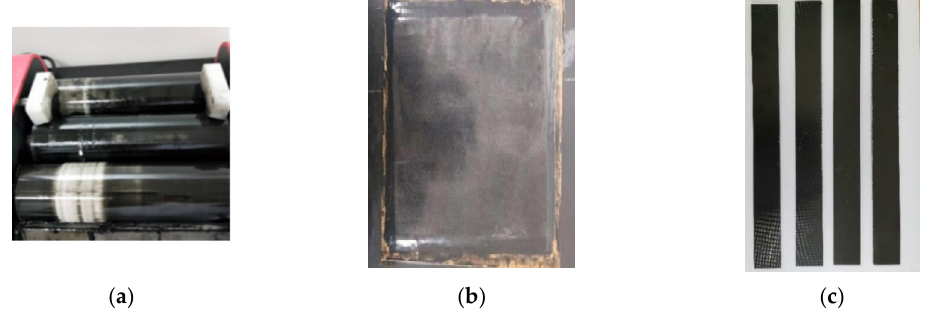
Figure 2. Fabrication procedures of the CNM-incorporated FRP composites ( a – c ). ( a ) Mixing by using a three-roll mill, ( b ) A multi-layered CNM-incorporated FRP composite made by hand lay-up, ( c ) Prepared FRP composite samples